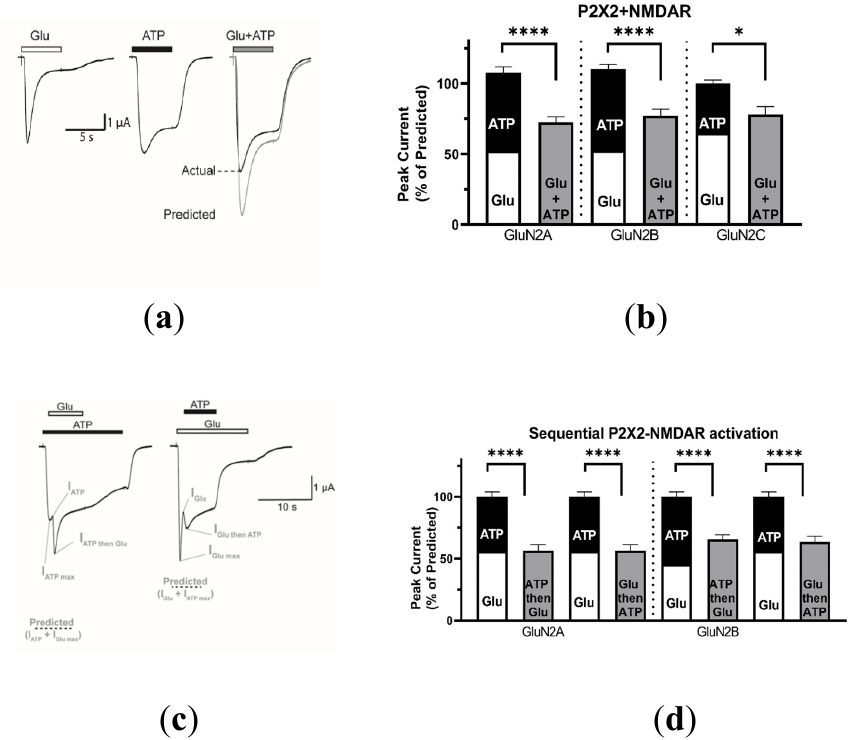
Figure 2. P2X2–NMDAR coactivation produces an inhibited response. ( a ) Representative current recorded from an individual oocyte coexpressing GluN2B-containing NMDARs and P2X2 responding to 100 µ M : Glu (left), ATP (middle), or Glu + ATP (right) are shown. ( b ) Bar graphs comparing the predicted and actual responses obtained from coapplication of agonists for P2X2 and NMDARs containing GluN2A ( n = 22), GluN2B ( n = 21), or GluN2C ( n = 6), normalized to the sum of the separate Glu and ATP responses for each oocyte. ( c ) Representative current from an individual oocyte coexpressing P2X2 and NMDARs containing GluN2B. For sequential activation of P2X2 and NMDARs, primary application of either ATP (left) or Glu (right) first appears to reduce subsequent coactivation responses. The predicted response when ATP is applied first is calculated as the sum of the current response to ATP immediately before Glu is coapplied and the maximum current response to Glu thereafter. This order is reversed when calculating the predicted response when Glu is applied first. ( d ) Bar graphs of P2X2 and GluN2A ( n = 16) or GluN2B ( n = 17) containing NMDARs, comparing the predicted and actual responses obtained from sequential activation and coapplication of agonists, normalized to the sum of the predicted current. The data are expressed as mean ± SEM; Statistical analysis performed using paired t-test * p < 0.05, **** p < 0.0001. 2.1.2. Coactivation of P2X2 and NMDA Receptors Produces Inhibited (Cross-Talk) Responses Given that both P2X2 and P2X4 are widely expressed in the CNS, we wanted to determine if P2X2 could also interact with NMDARs. In a similar manner, we coexpressed P2X2 and NMDARs in oocytes and recorded the currents evoked by application of ATP (100 µM), Glu (100 µM) or both agonists (100 µM each) (Figure 2). Similar to P2X4, P2X2 appeared to interact with NMDARs, as coactivation of P2X2 and NMDARs (containing GluN2A, GluN2B, or GluN2C) produced significantly lower responses than predicted (72.5 ± 3.8 %, n = 21, p = 0.0000022; 77.1 ± 4.8 %, n = 22, p = 0.000024; 77.9 ± 5.6 %, n = 6, p = 0.015, respectively). Unlike P2X4, NMDAR responses after P2X2